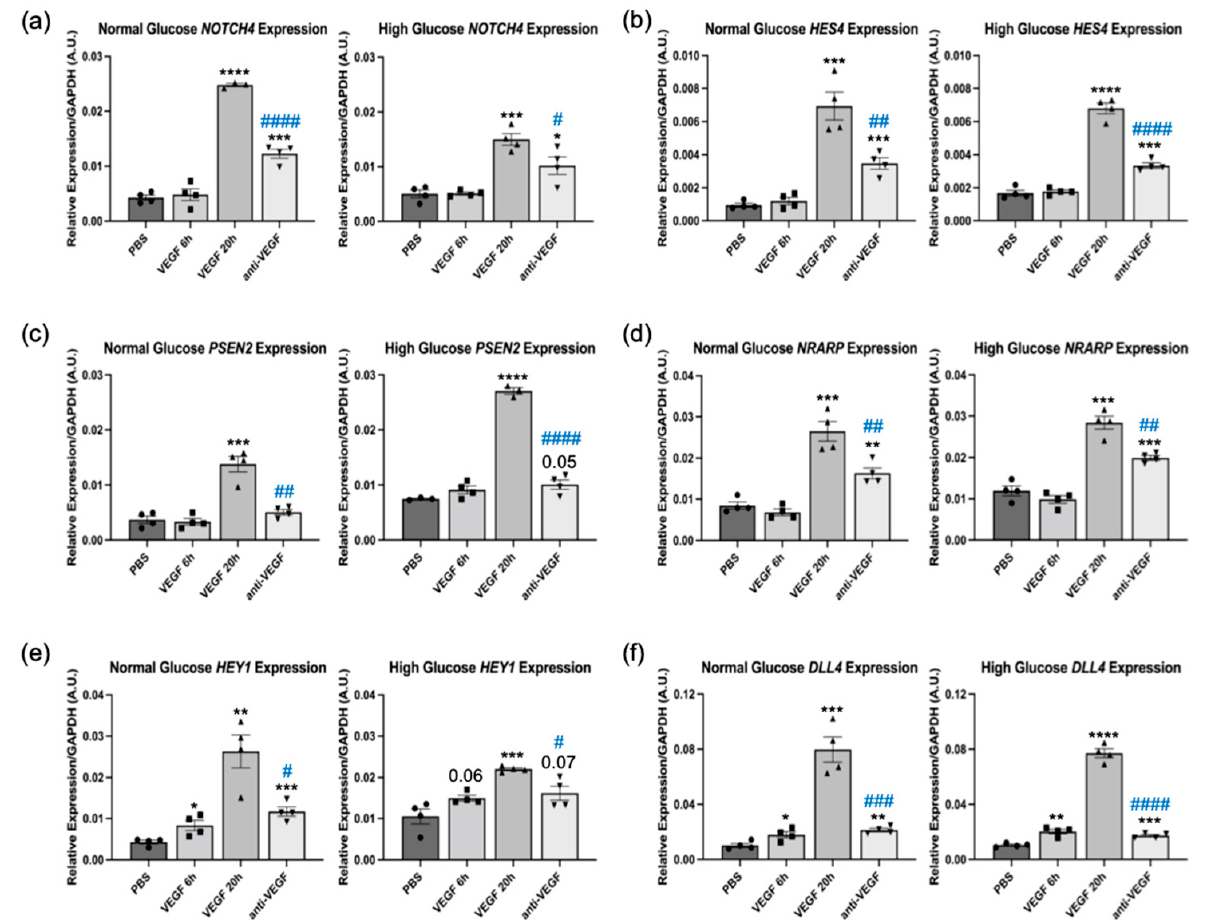
Figure 4. The maximal Notch response to VEGF occurred after 20 h. ( a – f ) Quantitative PCR for the expression of ( a ) NOTCH4 , ( b ) HES4 ( c ) PSEN2 , ( d ) NRARP ( e ) HEY1 , and ( f ) DLL4 in normal- and high-glucose HRECs treated with vehicle, 6 h VEGF, 20 h VEGF, or 6 h VEGF + 14 h anti-VEGF. Expression of genes of interest was normalized to GAPDH and presented as relative expression.